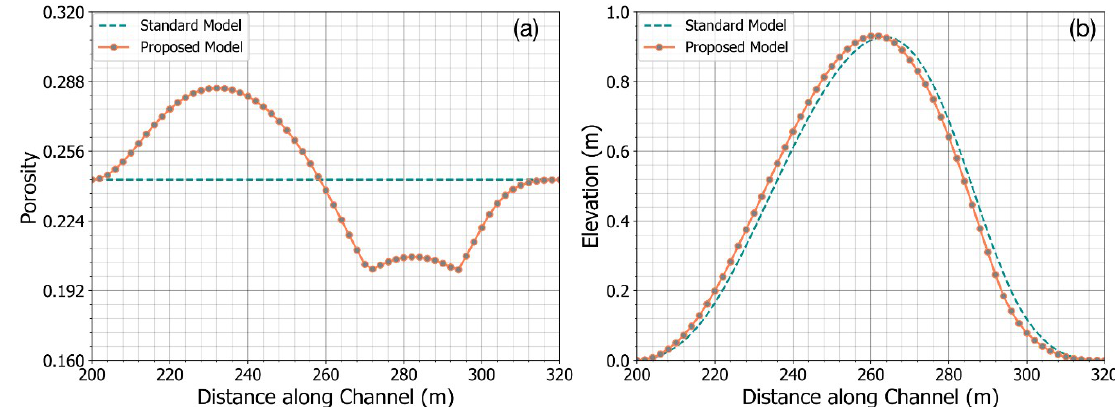
Figure 9. Comparison between the conventional model and the new model at the final time step ( a )—Porosity of the active-layer; and, ( b )—Bed elevation.